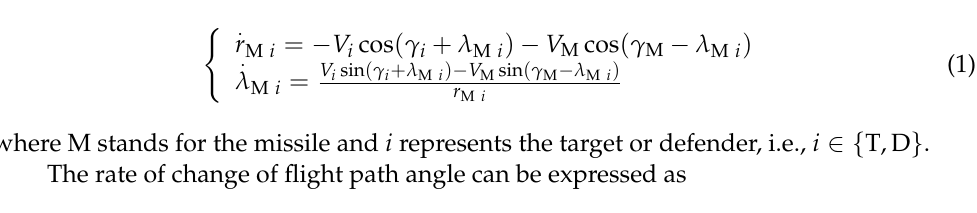
where M stands for the missile and i represents the target or defender, i.e., i ∈ { T, D } . The rate of change of flight path angle can be expressed as